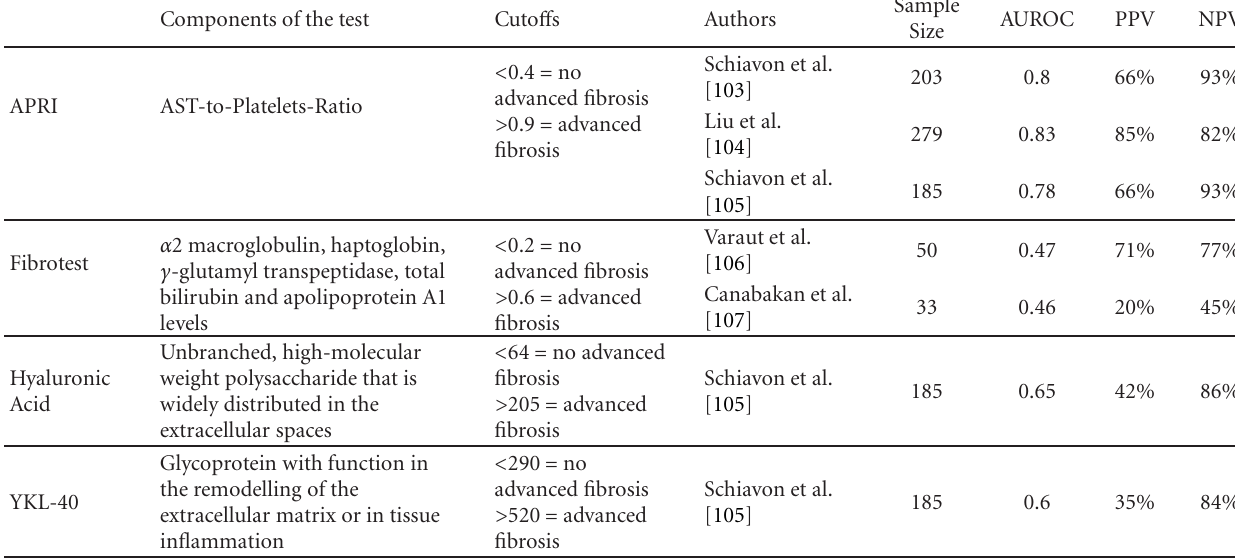
Table 3: Predictive value of serological markers for advanced liver fibrosis in HCV+ patients with end-stage renal disease. Components of the